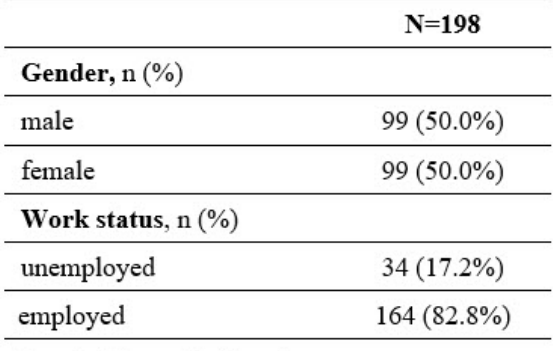
Table 1. Sample demographic charac- teristics